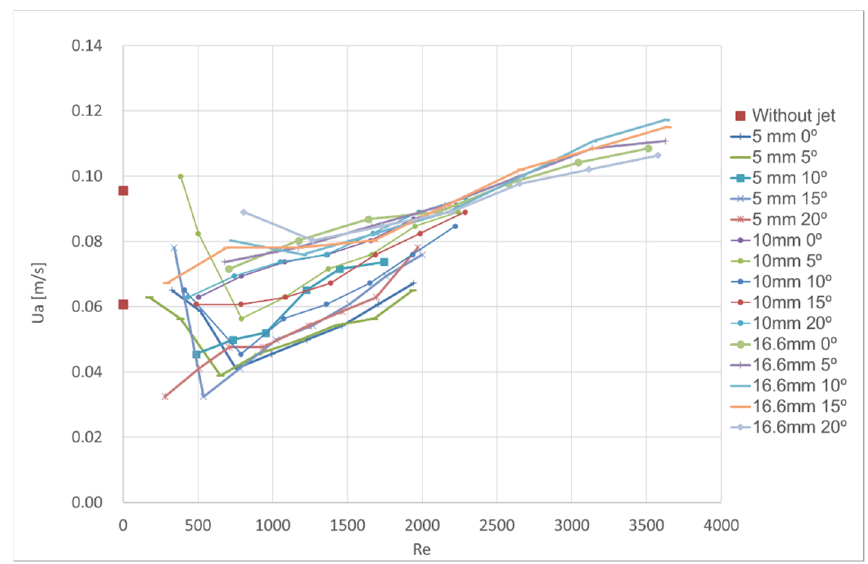
Figure 9. Test results for visual aerodynamic sealing of the air curtain (nozzle thickness and plane jet angle).